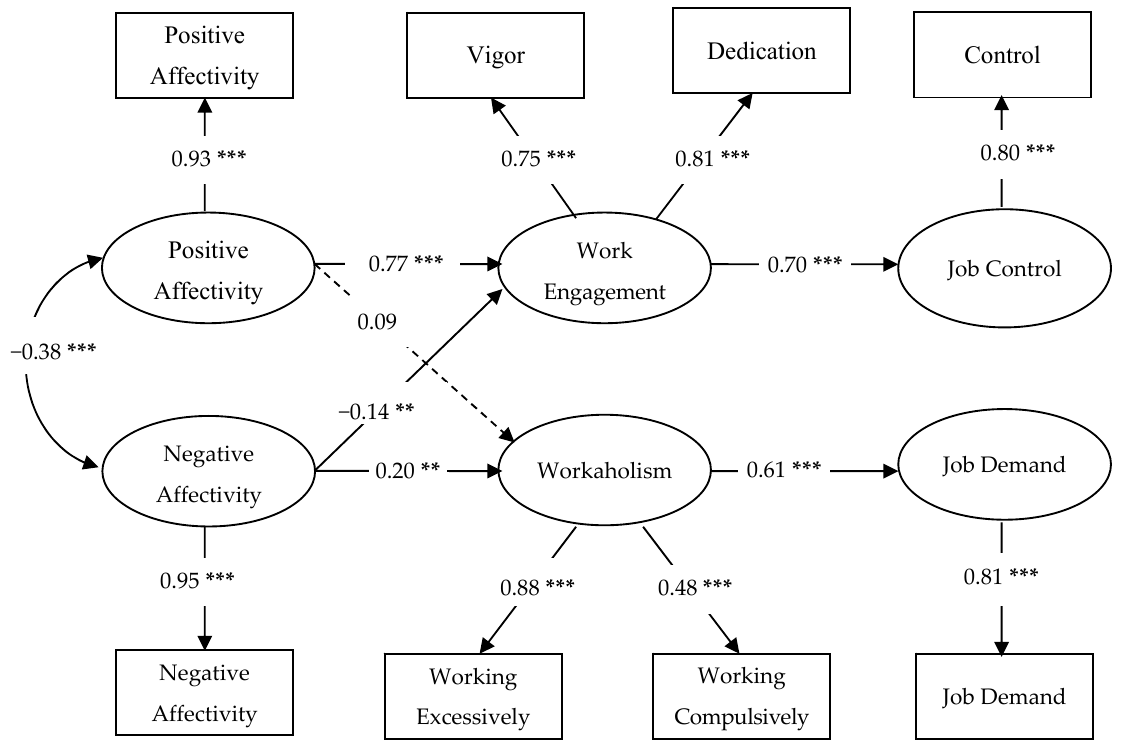
Figure 1. Standardized path coefficients of the full mediation model (M1). ** p < 0.01; *** p < 0.001; dotted lines denote non-significant effect.